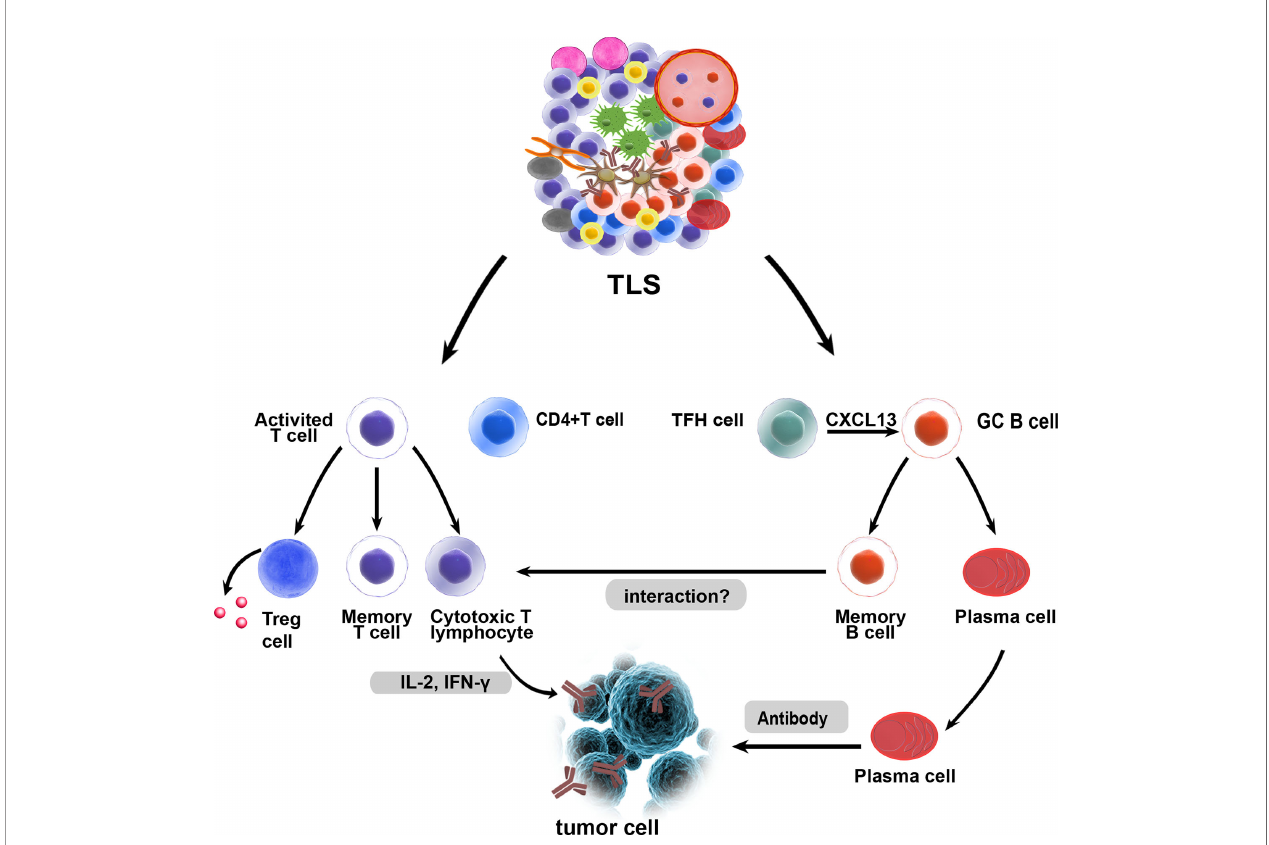
FIGURE 2 | Potential functions of tertiary lymphoid structures in the TME. As in canonical SLOs, TLSs may constitute a critical site where speci fi c T and B cells can undergo terminal differentiation into effector cells. GC B cells can differentiate into memory B cells and plasma cells in TLSs, and fully differentiated B cells and exert their antitumor effects. T cells can differentiate and expand, and they are activated as effector cells that exert cytotoxic effects. B cells and T cells in TLSs may interact with each other and play a synergistic role, which needs to be con fi rmed by more studies. Treg cells within TLSs could exert a negative in fl uence on the capacity of TLSs to generate effector and memory